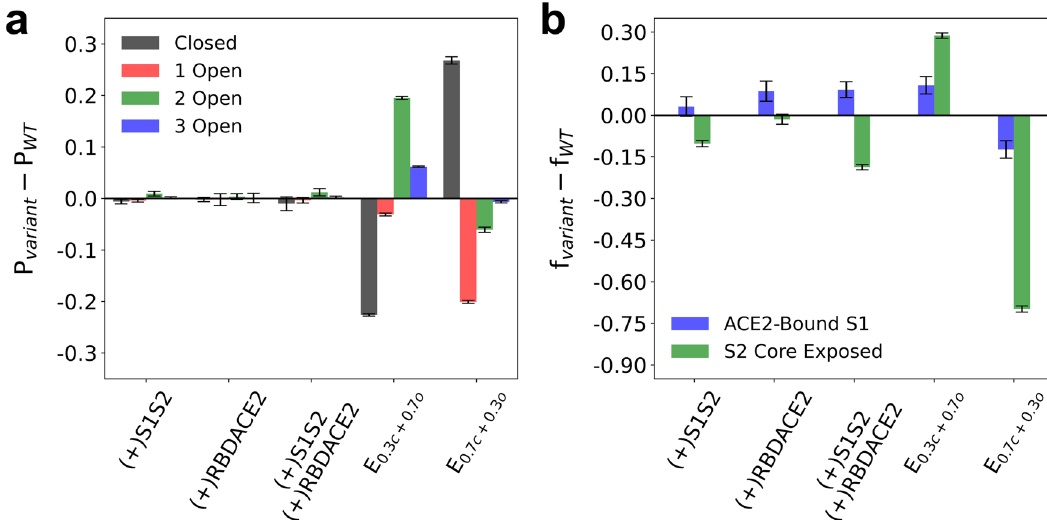
Fig. 5 Comparison of variant-emulating CG models to that of the wild type (WT). a Summary statistics for the difference in the probabilities of the closed (black), 1 RBD open (red), 2 RBD open (green), and 3 RBD open (blue) conformational states for the variants and that of the WT ( P variant − P WT ). b Summary statistics for the difference in the fraction of S1 monomers bound to ACE2 (blue) and spike trimers with complete exposure of the S2 trimeric core (green) for the variants and that of the WT ( f variant – f WT ); here, the stoichiometric ratio of ACE2 dimers to spike trimers is 2.56:1 (i.e., 64 ACE2 dimers to 25 spike trimers). The fi ve variant-emulating CG models are: enhanced S1 – S2 interactions (( + )S1S2), enhanced RBD-ACE2 interactions (( + )RBDACE2), enhanced S1 – S2 and RBD-ACE2 interactions (( + )S1S2( + )RBDACE2), increased open-state conformational sampling (E 0.3c + 0.7o ), and increased closed- state conformational sampling (E 0.7c + 0.3o ). All data points report the mean and standard error from triplicate